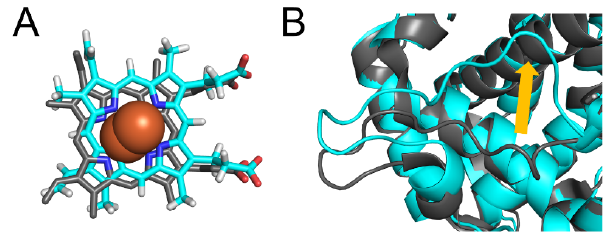
Figure 3. Structural deviation between the experimental and calculated structures. ( A ) The deviation of heme and ( B ) the K”L loop. The experimental structure and calculated structures are shown in gray and cyan, respectively. Nitrogen, oxygen, and hydrogen are displayed in blue, red, and white, respectively, in the stick model. Iron is shown as an orange sphere by a model written as van der Waals radius. The yellow arrow indicates the deviation of the K”L loop. Table 2. Secondary structure formation in >50% of trajectories for last 100 ns of simulations of the wild type 2A6.6, 2A6.11, 2A6.17, and 2A6.25 a .